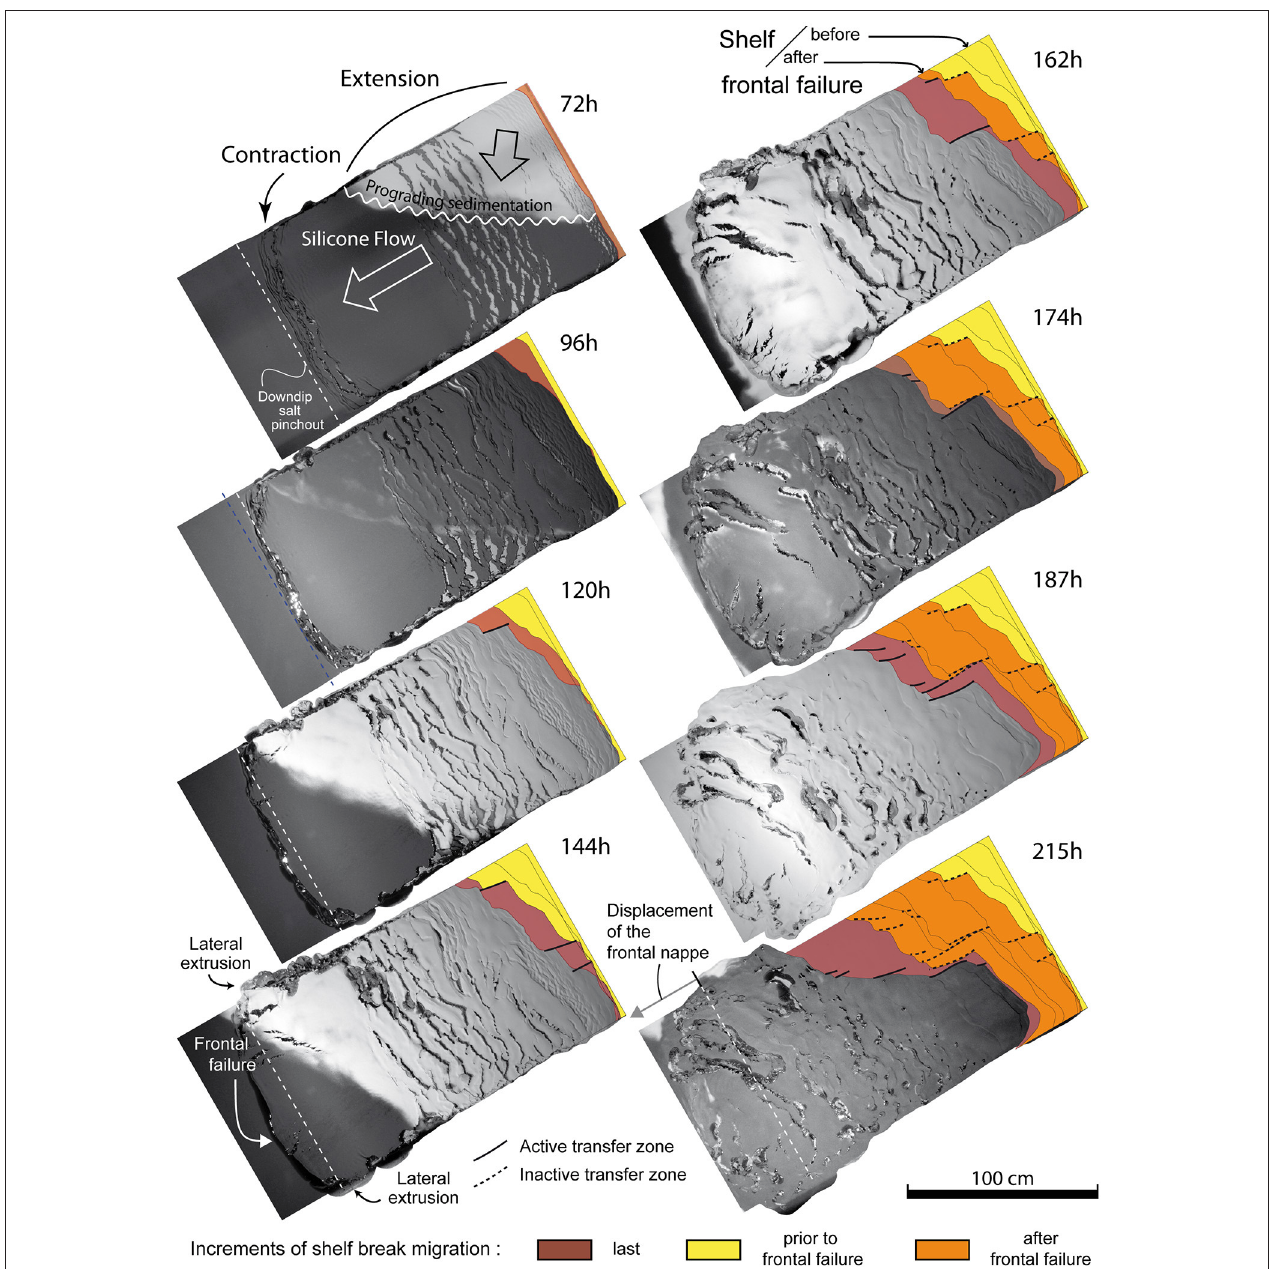
FIGURE 5 | Selection of model top views showing the progressive evolution of surface deformation and growth of the continental shelf. The duration since experiment onset is indicated for each snapshot. White arrows (at 72h): Directions of silicone (salt) flow and sediment supply.